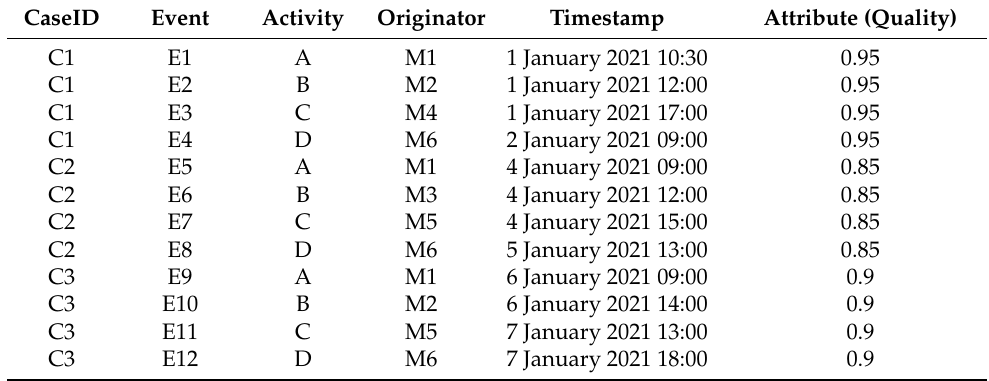
Table 1. A snippet of event